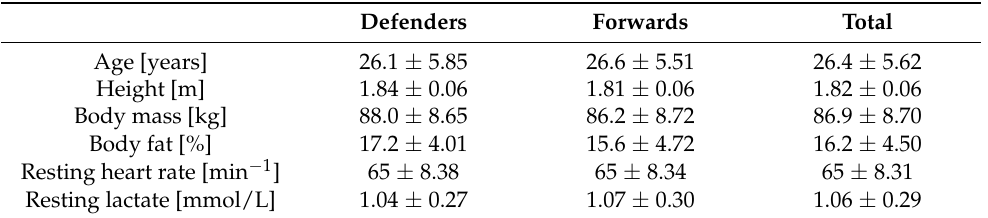
Table 1. Demographic and anthropometric characteristics of ice hockey players (n = 104; body fat: n = 83) in relation to playing positions (Mean ± Standard Deviation).